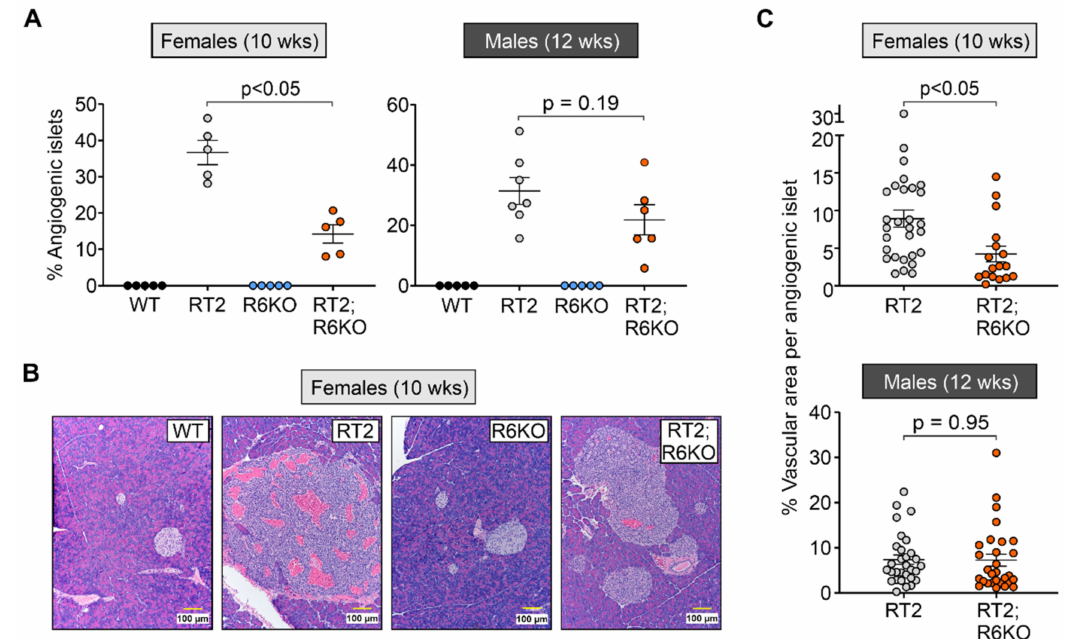
Figure 4. Loss of RABL6A reduces the angiogenic switch in RT2 mice. ( A ) Decreased percent angiogenic islets in 10-week- old female RT2; R6KO mice relative to RT2 controls. 12-week-old males trended similarly without statistical significance. Each dot equals data for an individual mouse pancreas. ( B ) Representative images of normal islets in 10-week-old female WT and R6KO mice versus angiogenic islets or tumors in RT2 and RT2; R6KO mice. Scale bar = 100 µ m. ( C ) Reduction in percent vascular area per angiogenic islet or tumor in RT2; R6KO 10-week-old females. WT and R6KO islets lack vasculature and are not shown. Each dot represents an individual angiogenic islet or tumor. Data in A and C are reported as the mean +/ − SEM. N = Females (WT = 5, RT2 = 5, R6KO = 5, RT2; R6KO = 5); Males (WT = 5, RT2 = 7, R6KO = 5, RT2; R6KO = 6). Beta regression model was used to evaluate differences in percent angiogenic islets and vascular area per angiogenic islet. Random intercepts were included to account for the correlated nature of angiogenic islets within the same mouse in the evaluation of the vascular area per angiogenic